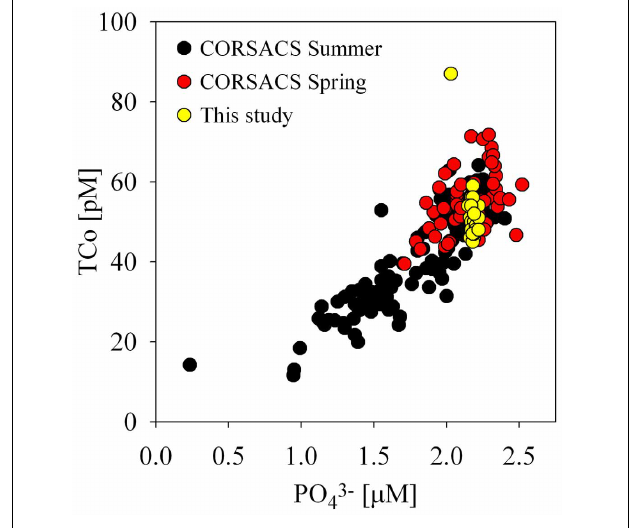
FIGURE 8 | A comparison of dissolved cobalt and phosphate relationships under the sea ice (this study) and in the Ross Sea Polynya (CORSACS spring and summer, Saito et al., 2010). The Co:PO 3 −